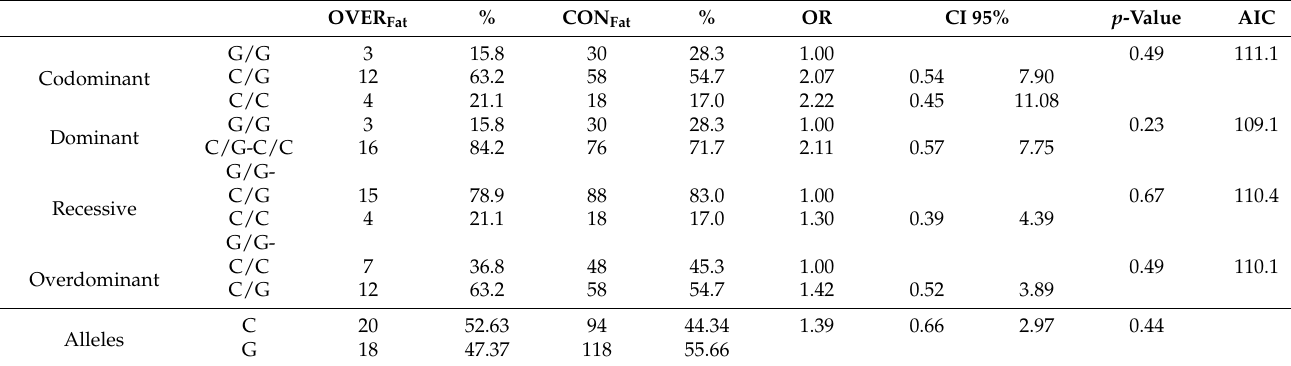
Table 4. Association analysis of the IL-6 rs1800795 polymorphism with fat%. OVER Fat % CON